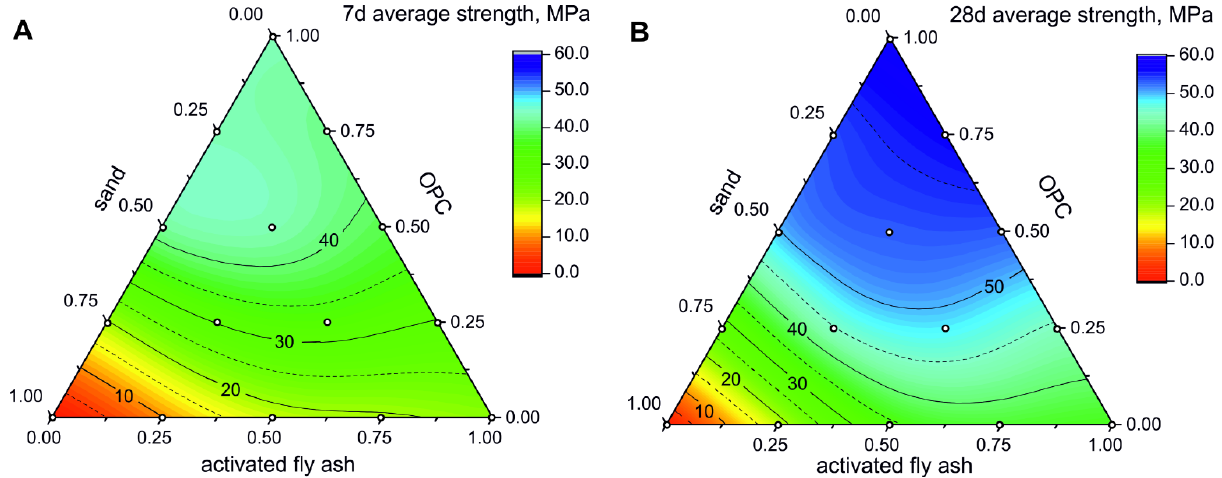
Figure 6. Uniaxial compressive strength of OPC ‐ FA ‐ CSA and sand mixtures after 7 ( A ) and 28 days ( B ) of hydration. Isolines show the uniaxial compressive strength in MPa. Empty circles mark the composition of the measured samples